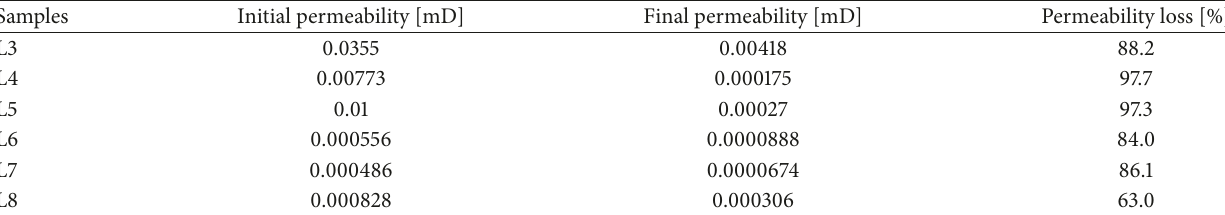
Table 3: The permeability loss after rock